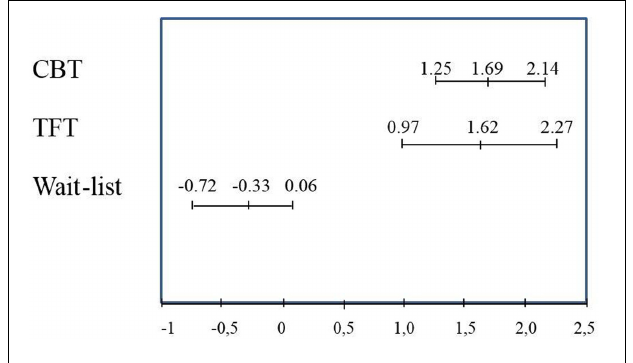
FIGURE 2 | Means and confidence intervals for changes on the ADIS symptom score for avoidance, from before to after wait-list ( n = 24) or treatment with CBT ( n = 24) or TFT ( n = 24).